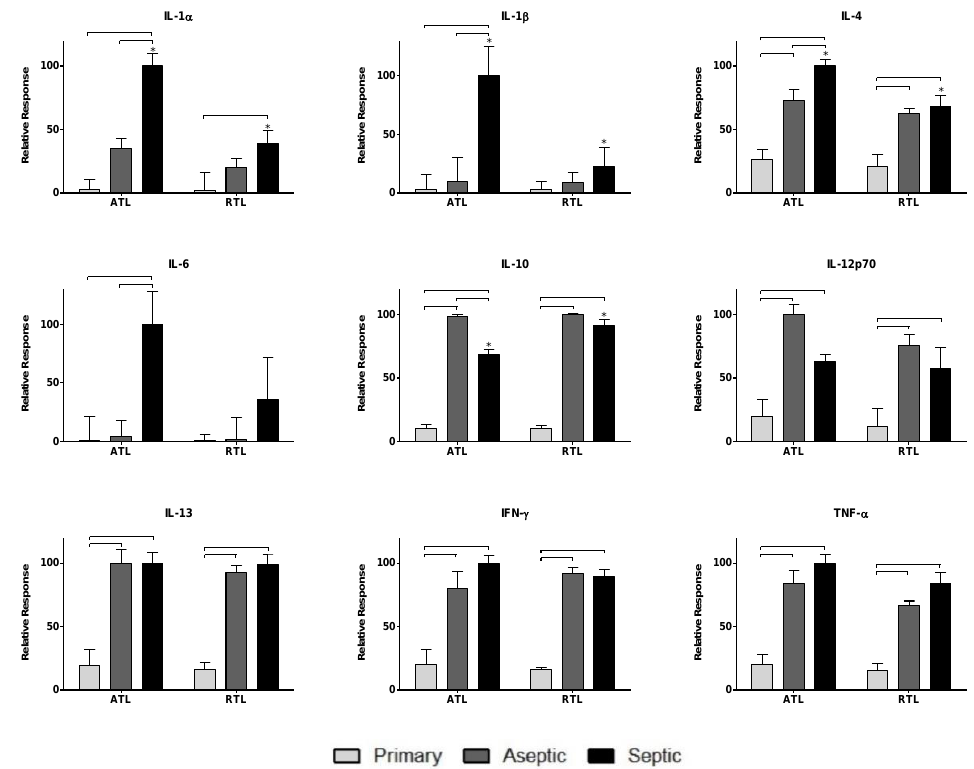
Figure 2. Relative cytokine levels measured in tissues from primary TKA, aseptic TKR, and septic TKR at adjacent tissue layer (ATL) and radial tissue layer (RTL) debridement depths. Relative cytokine responses (normalized to highest cytokine signal) were observed for all three patient groups: primary, aseptic, and septic at two debridement depths: ATL is closer to the knee joint, and RTL is approximately 1 cm removed from the knee joint. Statistically significant differences ( p < 0.05) were determined by two-way ANOVA with Bonferroni’s post-test to examine group-dependent and spatially-dependent differences in cytokine relative response. Differences for the same group (i.e., septic) between ATL and RTL are marked with an asterisk (*). Differences between groups within a tissue layer are denoted with bars. Responses are shown as the mean ± SEM.